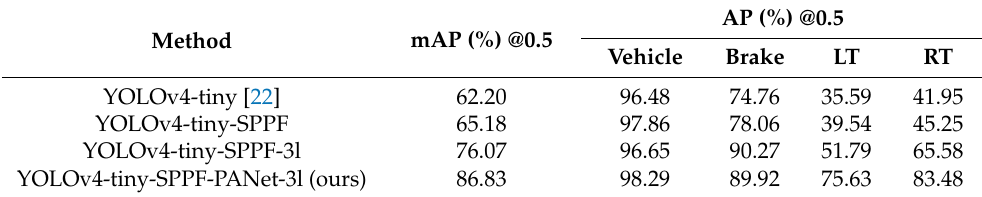
Table 4. AP results of the ablation experiment on the test